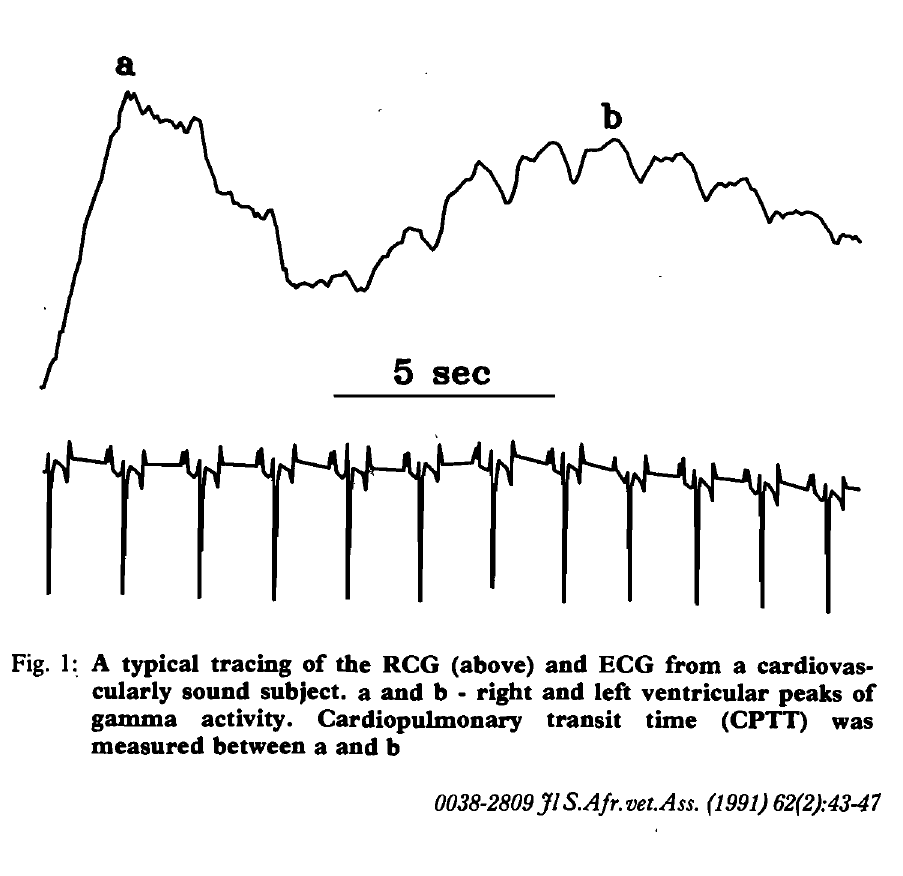
Fig. 1:, A typical tracing of the RCG (above) and ECG from a cardiovas cularly sound subject. a and b - right and left ventricular peaks of gamma